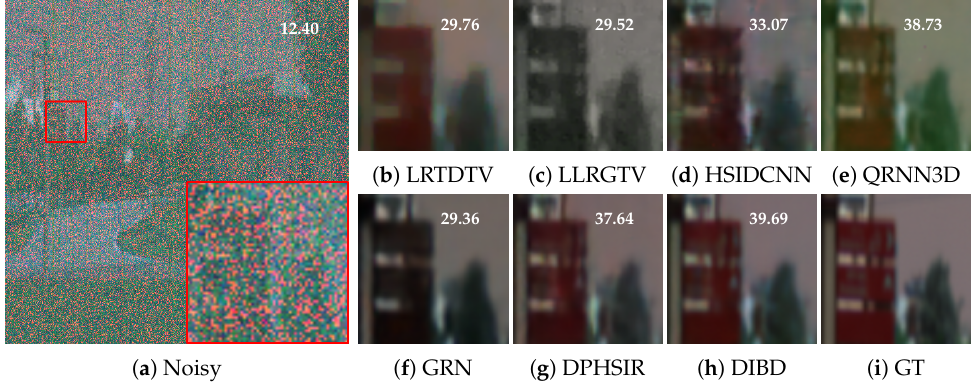
Figure 5. Denoising results (PSNR, dB) and visual comparison of the image from ICVL dataset under noise case 5. The RGB image is synthesized by HSI bands 8, 18, 28.